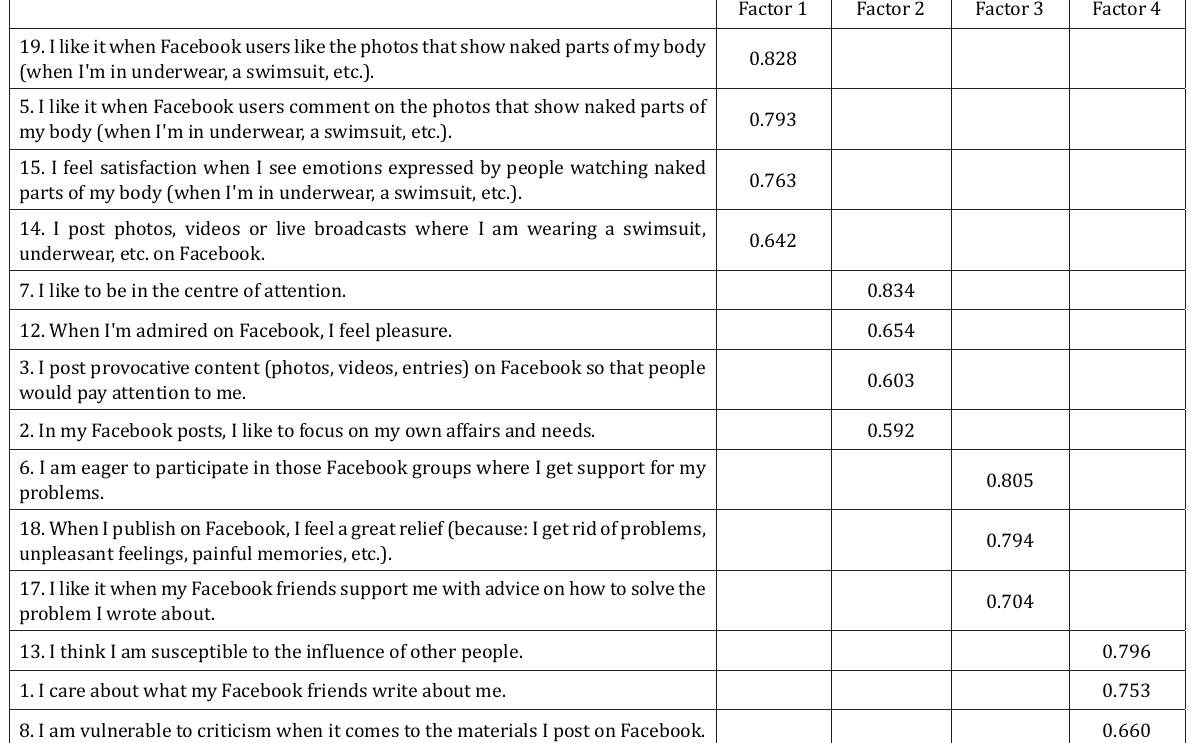
Table 1. The compound matrix for identified factors